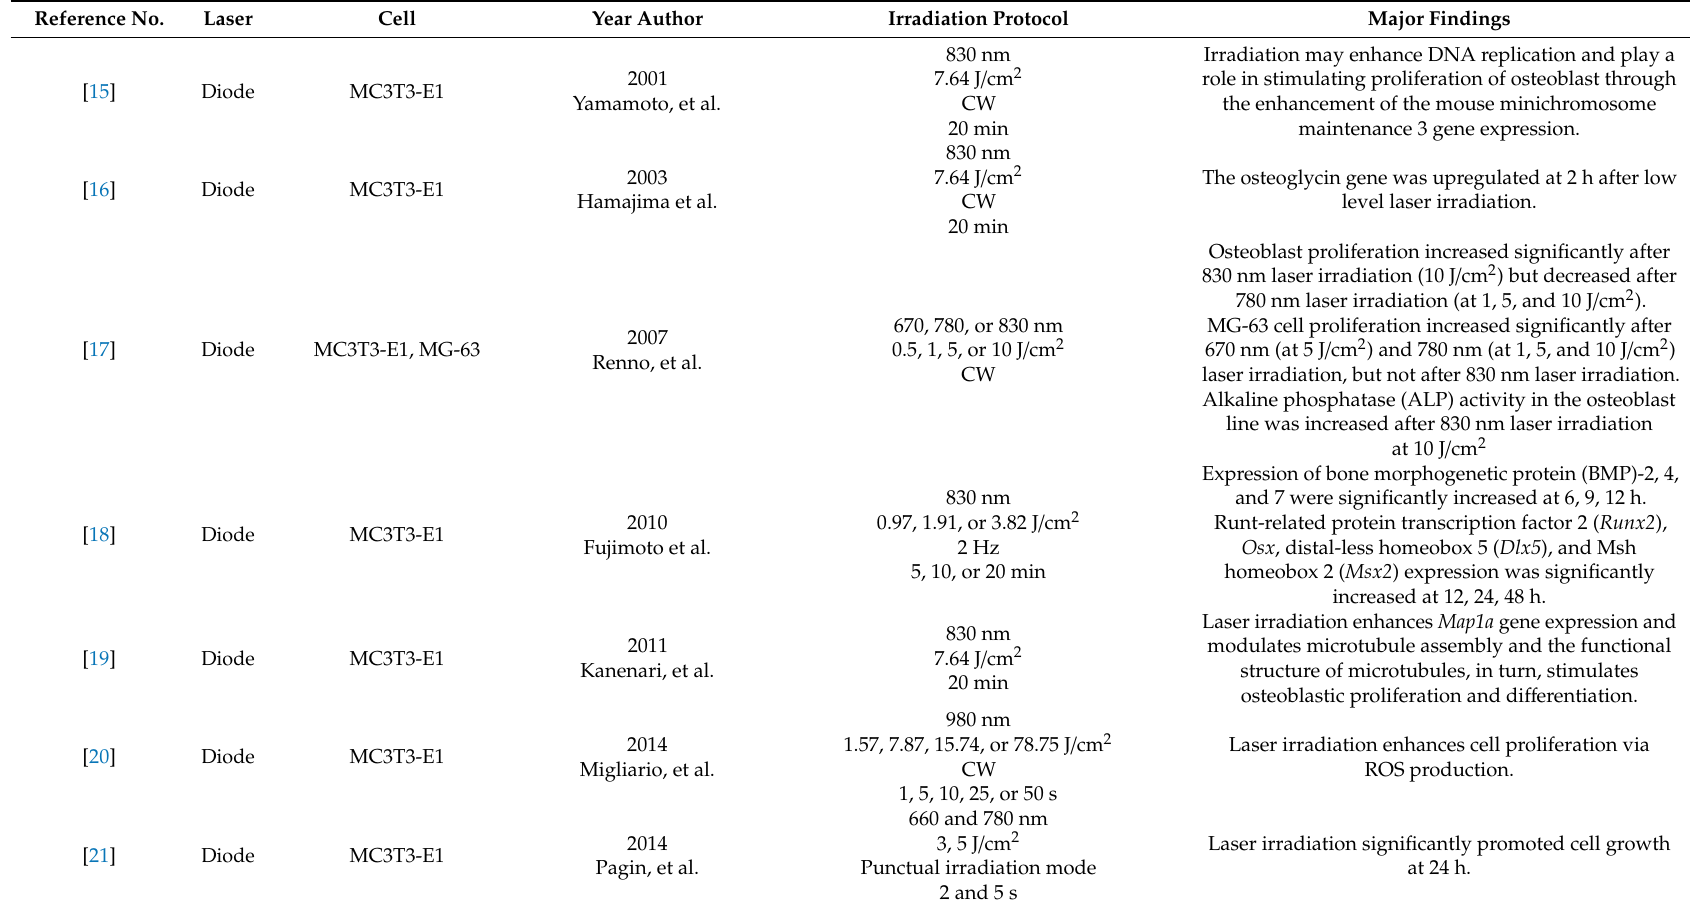
Table 1. Summary of the e ff ects of laser irradiation on